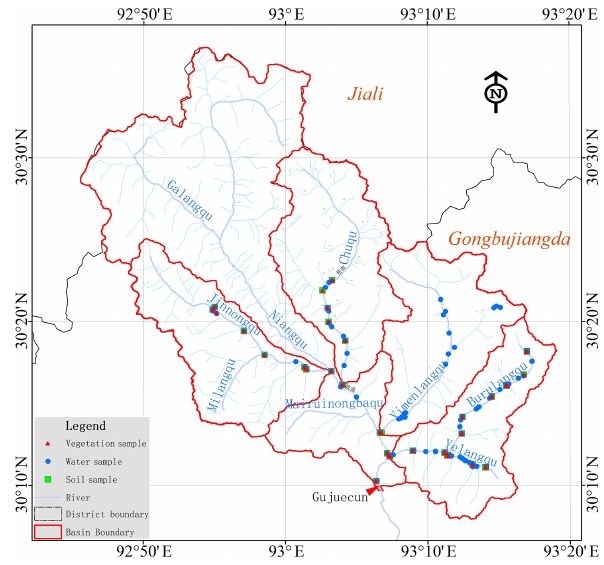
Figure 5. Sampling points in the field